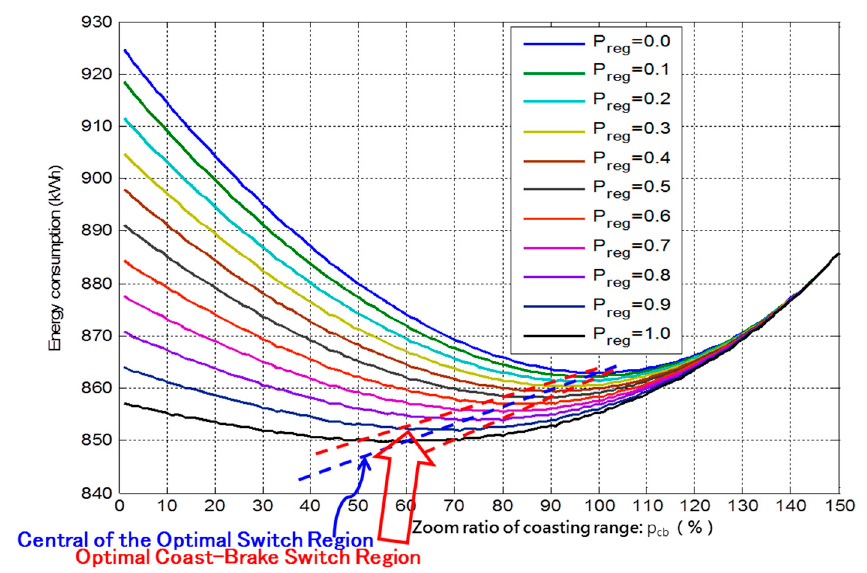
Figure 7. Approximate linearization of the optimal coast ‐ brake switching region.